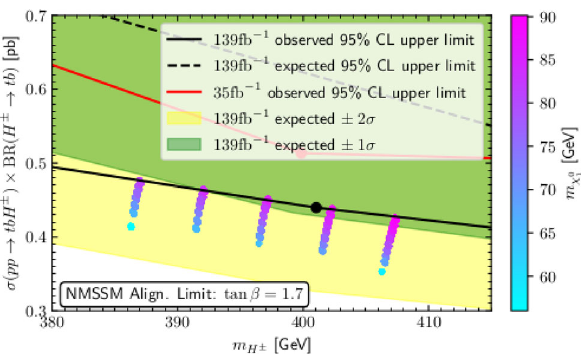
Fig. 14 NMSSM parameter points with χ 2 ≤ χ 2 Fig. 15 NMSSM parameter points with χ 2 ≤ χ 2 and for which SM σ( pp → tbH ± ) × BR ( H ± → tb ) plane.Thecolorsofthepointsindi- ≤ 98 in the μ μ 94GeV ≤ m h CMS – LEP plane. The colors of the points S indicate the values of m h cate the values of m (cid:16) χ 0 . Also shown are the current observed (black) and S 1 expected (black dashed) upper limits at the 95% CL and the expected 1 σ (green) and 2 σ (yellow) exclusion regions obtained by ATLAS [96]. The red line indicates the previous ATLAS result for the observed upper limit using 35fb − 1